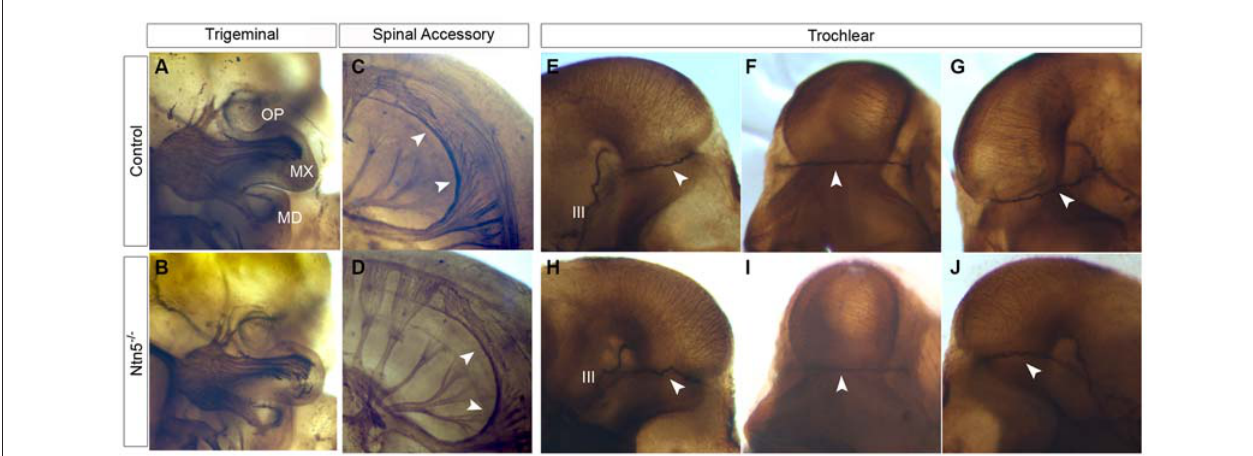
FIGURE 6 | Cranial nerves develop normally in Ntn5 − / − mutants . To visualize cranial nerves, whole embryos were stained for neurofilament at E11.5. The three branches of the trigeminal nerve were positioned normally in both controls (A) and mutants (B) . The three branches are labeled as OP (ophthalmic) MX (maxillary) and MD (mandibular). Likewise, the spinal accessory nerve was not visibly reduced and exhibited normal pathfinding in Ntn5 − / − mutants (C,D) . Cranial nerve IV, the trochlear nerve, extended dorsally to cross at the back of the head to innervate the contralateral side in controls (E − G) and mutants (H − J) . The oculomotor nerve (III) is also visible in these images. All observations were verified in five mutant and five control embryos.